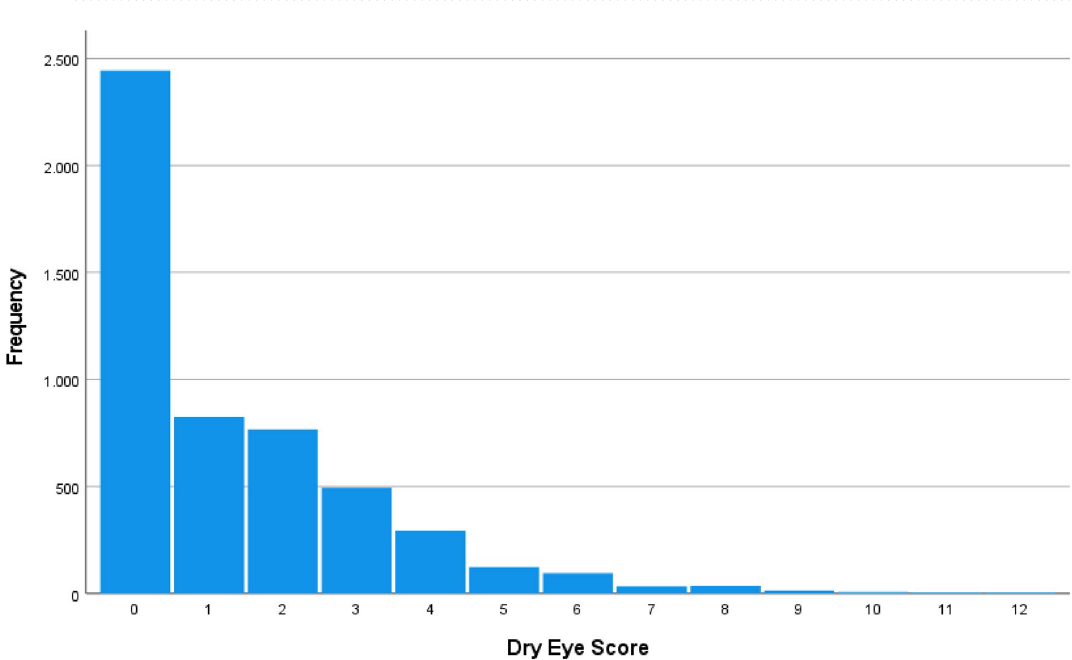
Figure 2. Histogram showing the distribution of the total score of the dry eye symptoms in the Ural Eye and Medical Study The prevalence and degree of a DED were assessed by specific questions in the questionnaire and by additional physical examinations. The questions were: 1) Do our eyes feel dry; 2) Do you ever feel a gritty or sandy sensation in your eye; 3) Do your eyes ever have a burning sensation; 4) Are your eyes ever red; 5) Do you notice much crusting on your lashes; and 6) Do your eyes ever get stuck in the morning. All questions were answered using a scale of grade 0 for “never”, grade 1 for “rarely or sometimes”, and grade 2 for “frequently or always”. A quantitative grading score of the subjective dry eye symptoms was obtained by summarizing the grades of the answers to the six questions